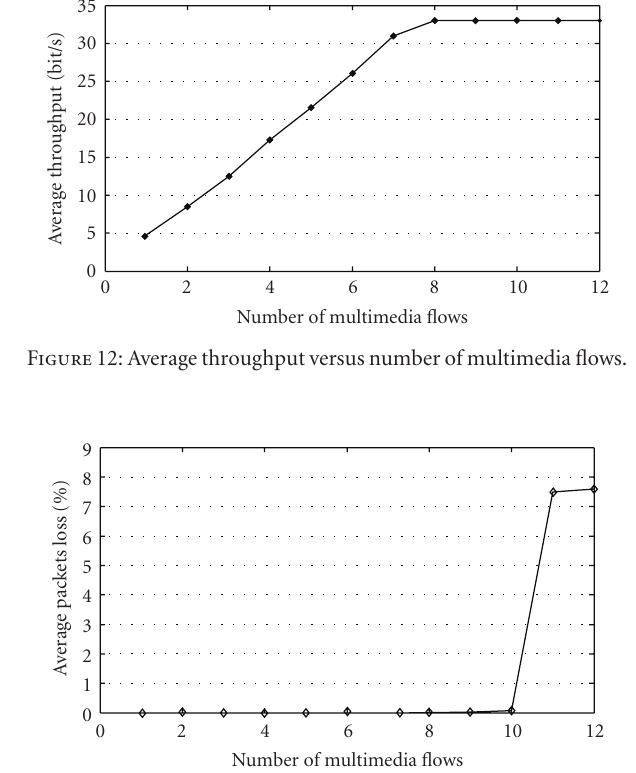
Figure 13: Average packets loss versus number of multimedia flows. sessions (the average bit rate is about 480 kb/s). It is clearly shown in Figure 12 that the proposed configuration supports a maximum number of 10 parallel sessions. For this number of sessions, throughput is maximized (as it is observed in Figure 13) and the packets loss is insignificant ( (cid:2) 1%). However, additional flows impact very badly the